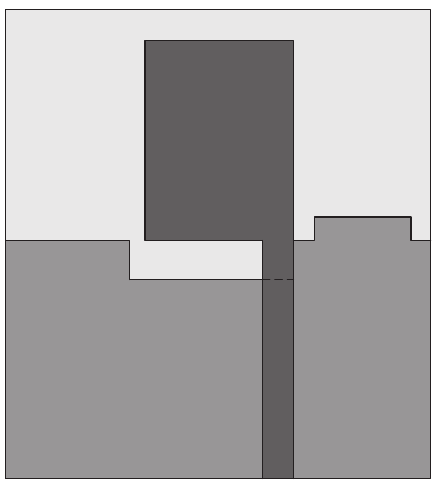
Figure 16: A microstrip-fed broadband circularly polarized monopole antenna with a stub integrated in the ground plane [36]. Dark gray upper metal face, medium gray bottom metal face, and light gray dielectric substrate.